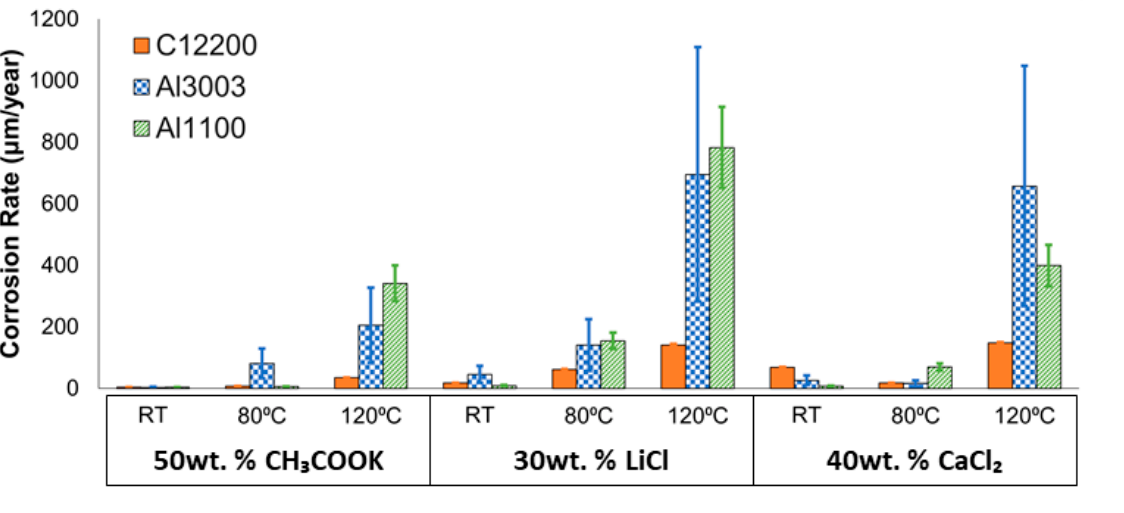
Figure 4. Corrosion rates of metal alloy samples in liquid desiccant solutions at various temperatures. In all cases, corrosion rates in CH 3 COOK were lower than in chloride salts. Table 3. Variation of experimental conditions for corrosion experiments in CH 3 COOK.